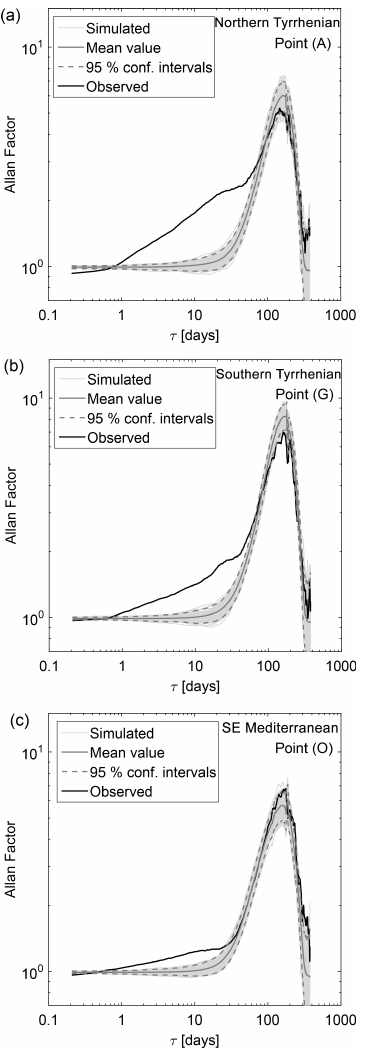
Figure 7. Comparison of Allan factor between hindcast data series for 98% percentile (black line) and 1000 simulated cyclic Poisson processes (grey lines). The AF corresponding to the 95% percentile of the AF distribution is also plotted (dashed line). Top left shows point A (northern Tyrrhenian). Top right shows point G (southern Tyrrhenian). Bottom shows point O (south-eastern Mediterranean).